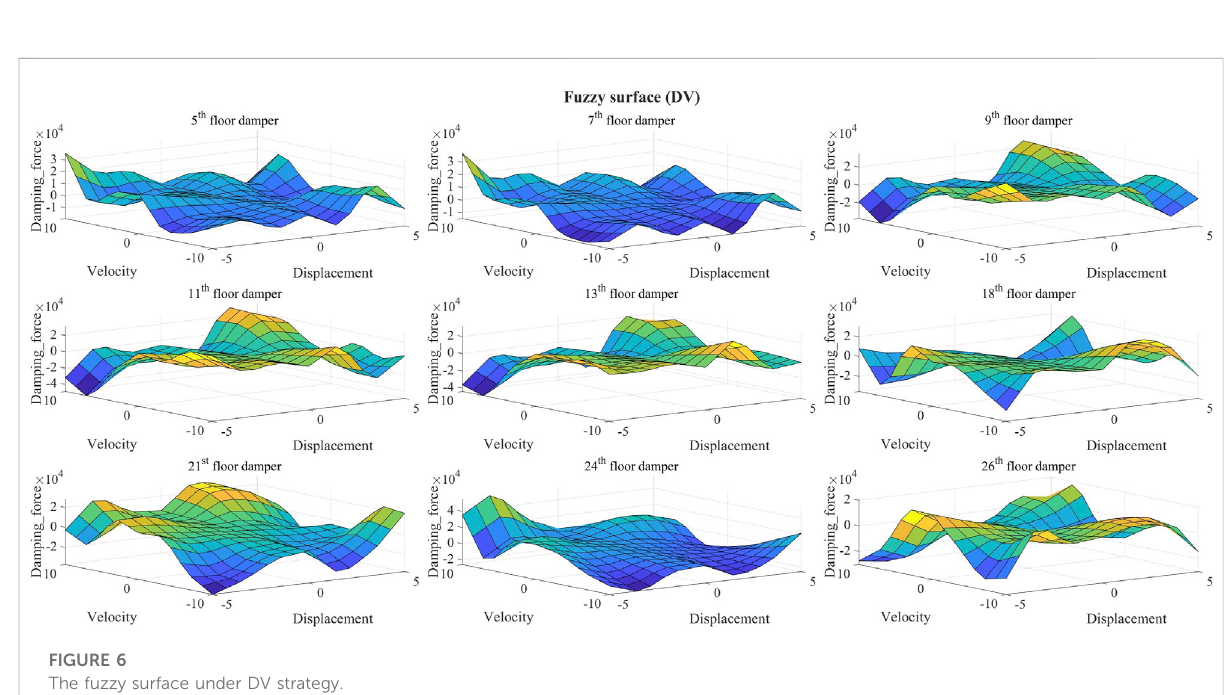
FIGURE 6 The fuzzy surface under DV